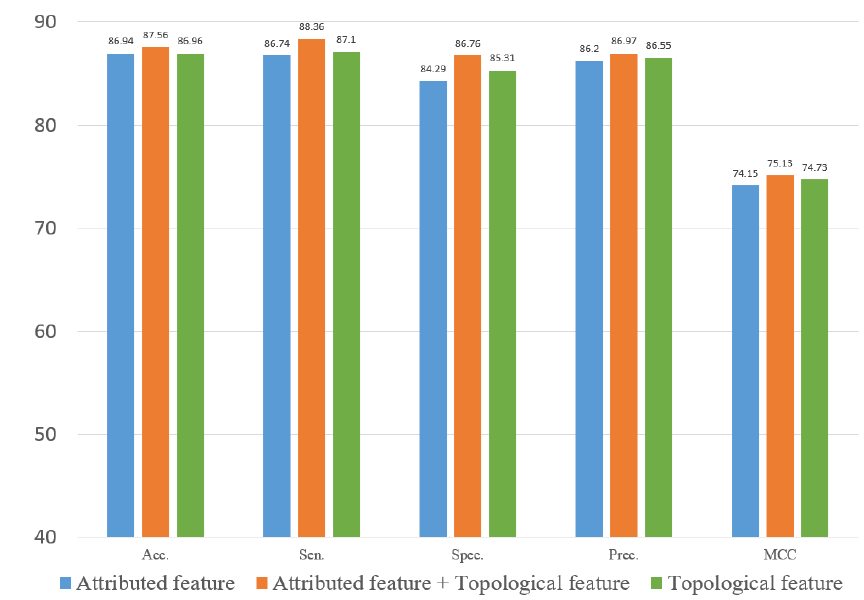
Figure 11. Result of ablation experiment on the RNAInter dataset.